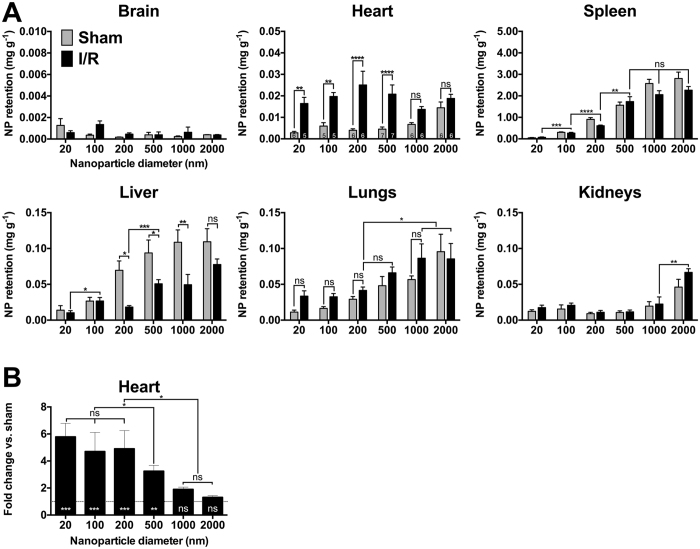
HPLC Analysis of PEG modified Fluorescent Polystyrene Nanoparticle Biodistribution Following I/R Injury.(A) Increased retention of nanoparticles with core diameters of 20, 100, 200 and 500 nm (hydrodynamic diameters of 65, 136, 226 and 548 nm respectively) occurs in the heart following I/R injury. Larger nanoparticles show a greater degree of off target retention, particularly by the spleen. (B) Expressing nanoparticle retention by the heart in terms of fold change in I/R vs. sham mice shows a clear size dependent accumulation. Statistical annotations inside the base of each bar show comparisons between retention in I/R and sham operated mice. Error bars show the standard error of the mean. The number of animals per group is shown in (A) for the heart. * = P ≤ 0.05, ** = P ≤ 0.01, *** = P ≤ 0.001, **** = P ≤ 0.0001, ns = P > 0.05.